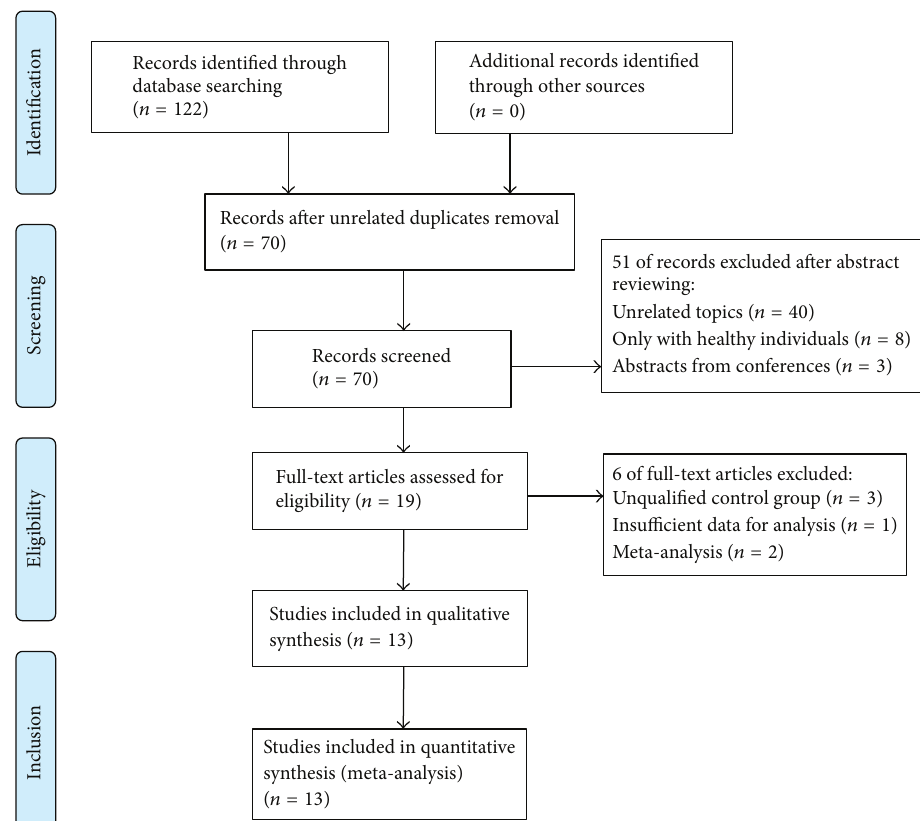
Figure 1: Flow diagram of the selection process in the